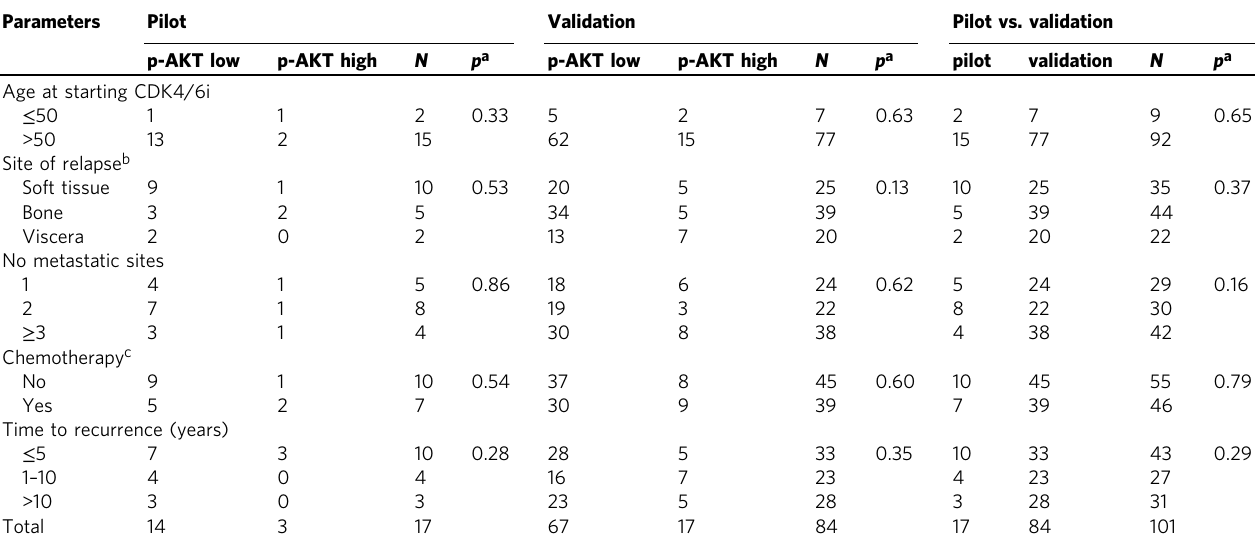
Table 1 Clinical and pathological characteristics of ER + breast cancer patients with advanced disease treated with combined CDK4/6i and endocrine treatment from pilot and validation cohorts according to p-AKT levels. Parameters